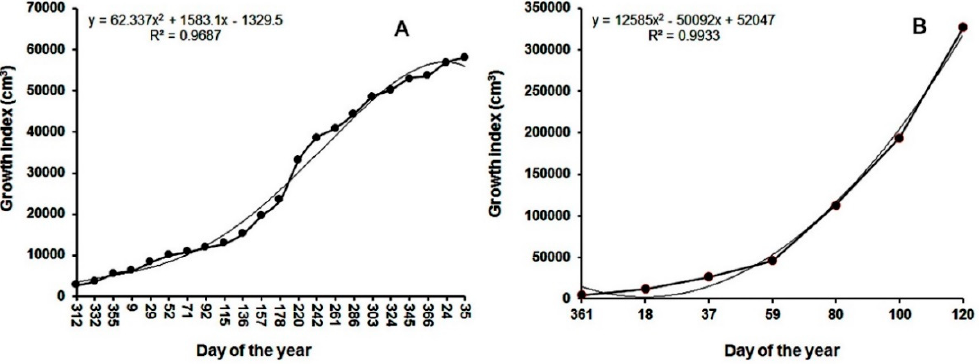
Figure 1. Growth indices (cm 3 ) of Davallia bullata ( A ) and Nephrolipis exaltata ( B , crop 2) grown in 15 cm plastic containers from liners to marketable sizes. The equations are the best fit line (thin line). Table 1. Plant growth parameters measured at harvest by species. They were harvested once their common commercial canopy sizes were attained z